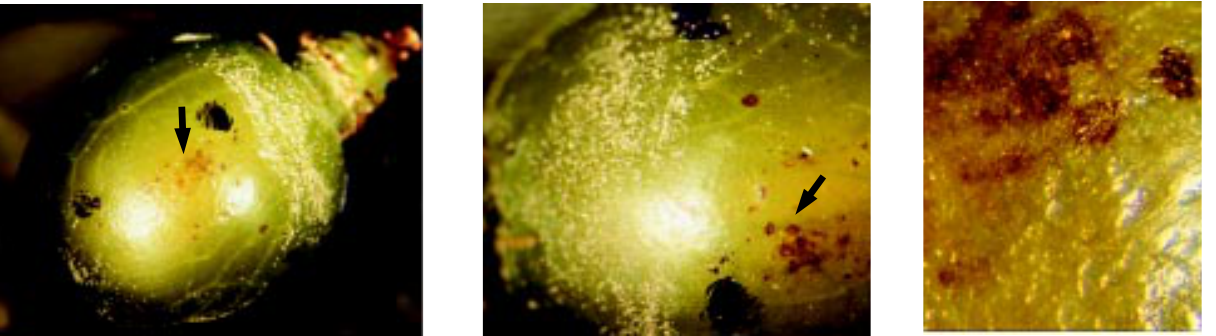
Fig. 4. Esca-like lesions (arrows) produced when berries were rubbed with carborundum dust prior to inoculation with Pm. aleophilum P99.4. Photos from left to right show increasing magnification, 6.3, 10, 20 (cid:1) . Similar lesions were produced on berries inoculated with Pm. aleophilum P99.10 and Pa. chlamydospora P99.16.